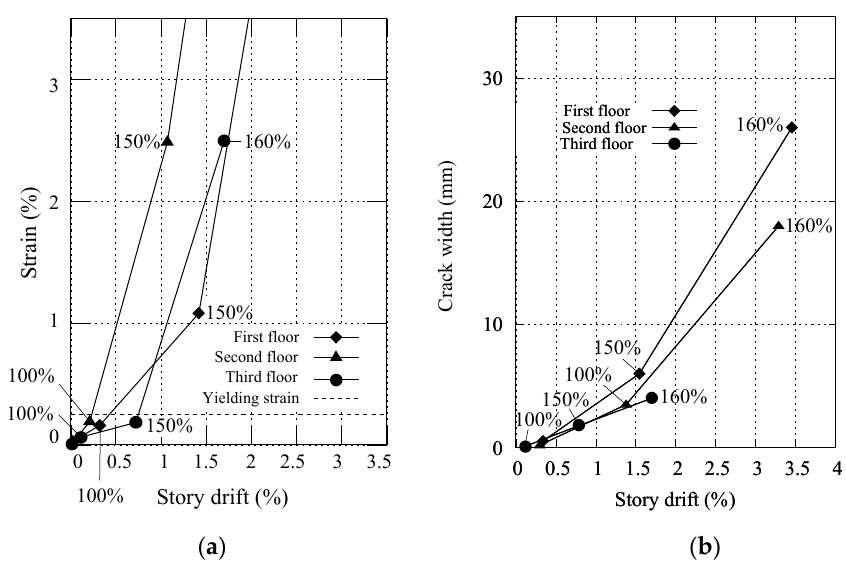
Figure 18. Comparisons of the hanging walls under different earthquake waves: ( a ) story drift–strain; ( b ) story drift–crack widths.